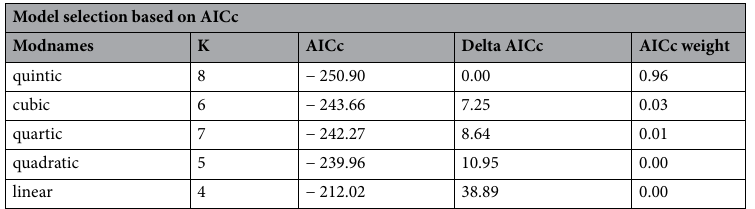
Table 2. Model selection table for the criterion. The best-fit model is listed first. K, the number of parameters in the mixed model including fixed and random effects. AICc, Akaike Information Criterion corrected for small sample sizes, the smaller the AIC value, the better the model fit. Delta AICc, the difference in AIC score between the best model and the model being compared. AICc weight, which is the proportion of the total amount of predictive power provided by the full set of models contained in the model being